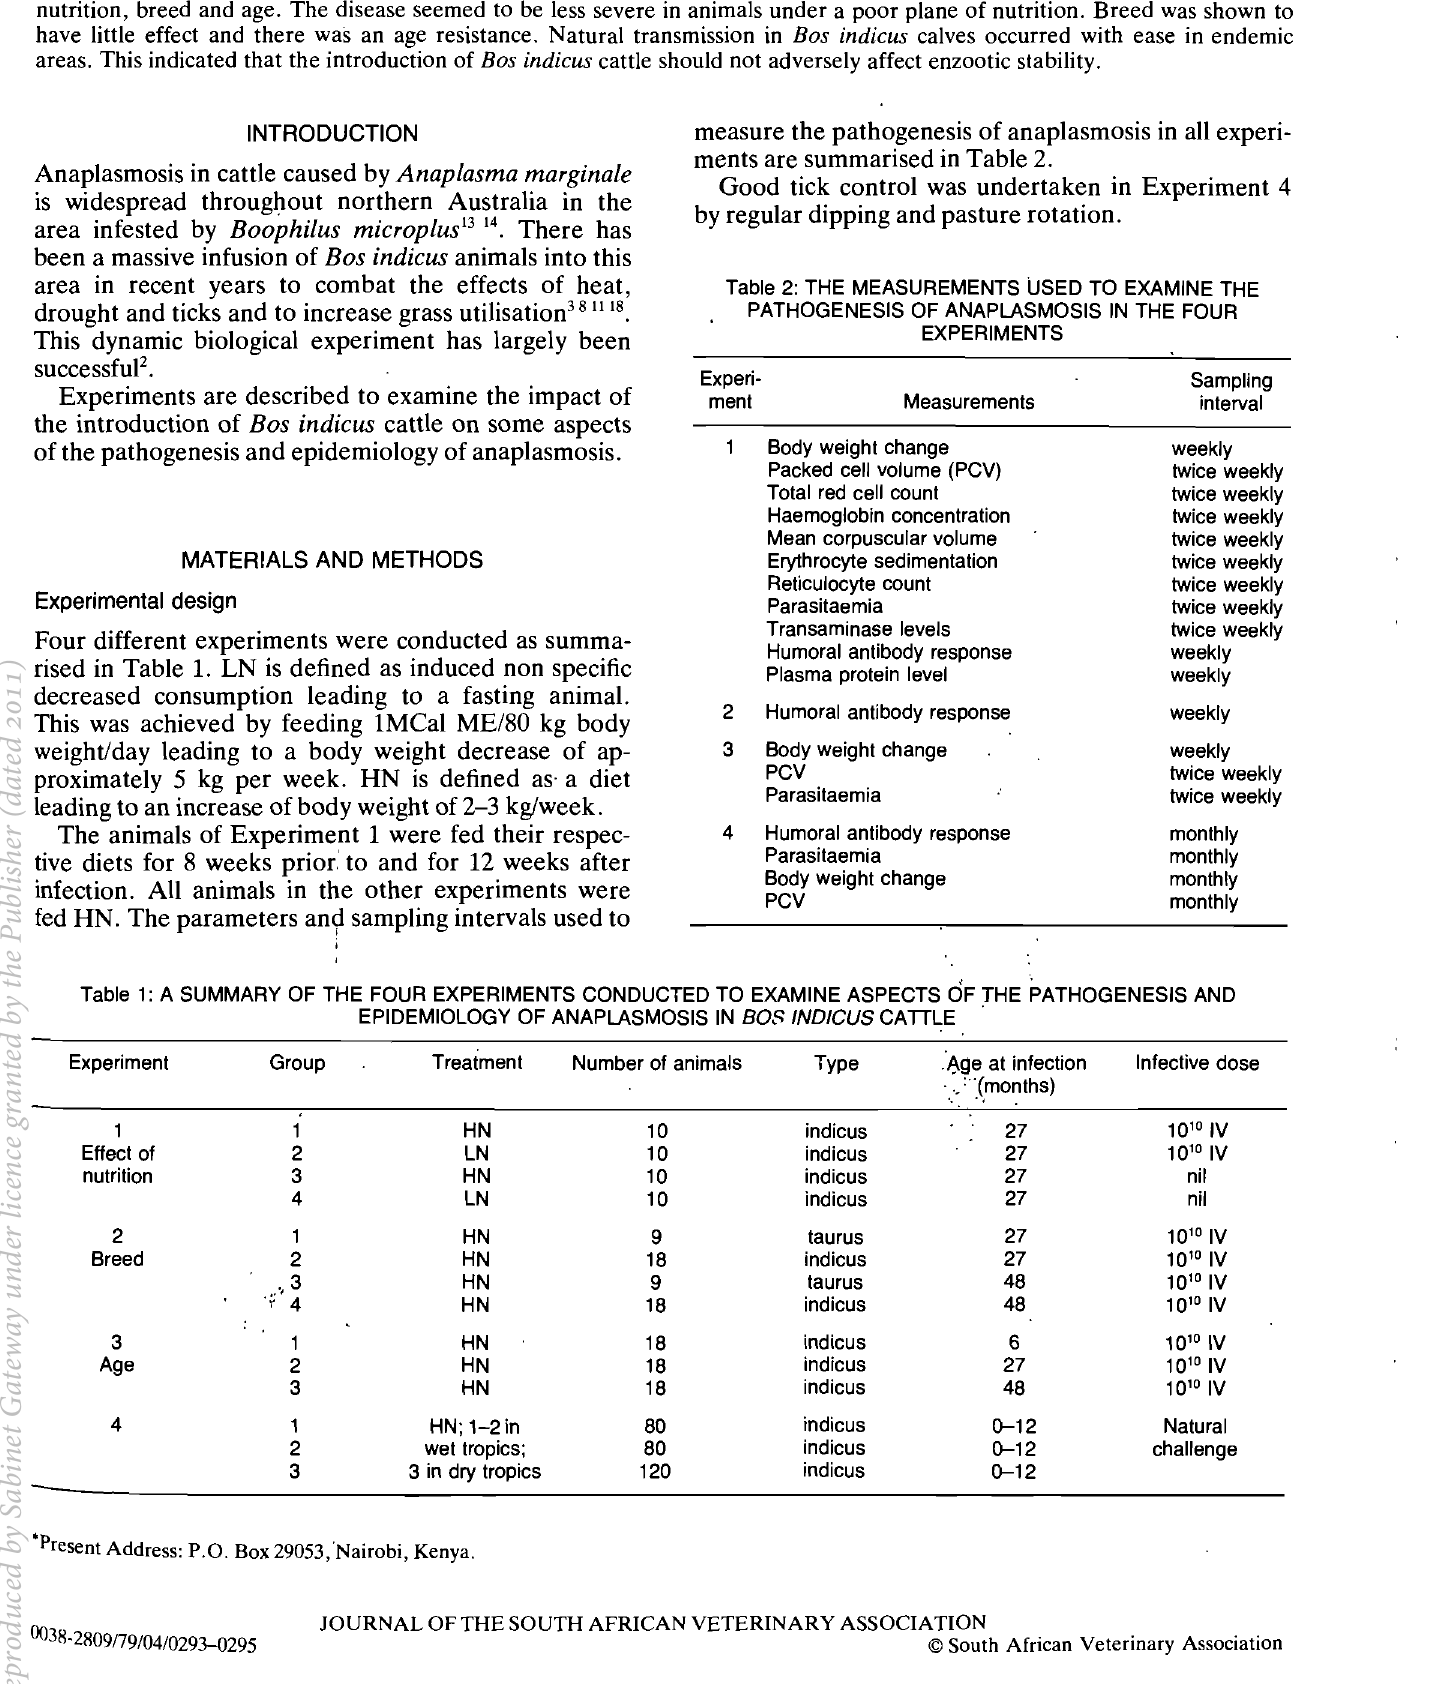
Table 1: A SUMMARY OF THE FOUR EXPERIMENTS CONDUCTED TO EXAMINE ASPECTS OF THE PATHOGENESIS AND EPIDEMIOLOGY OF ANAPLASMOSIS IN BOS /NO/CUS CATTLE .